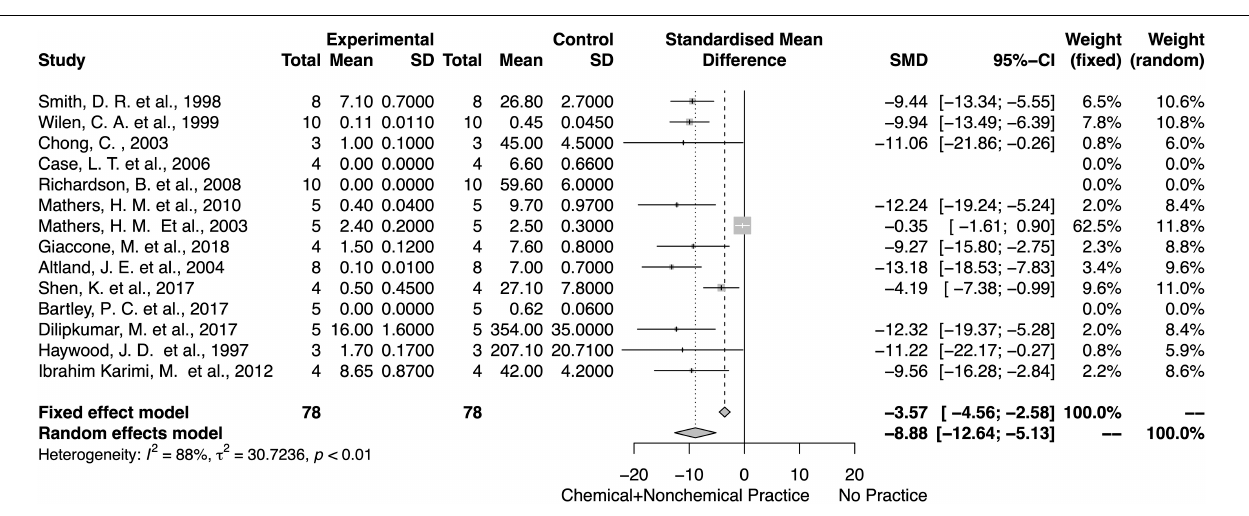
FIGURE 9 | Meta-analysis for the non-chemical weed control method on weed density.